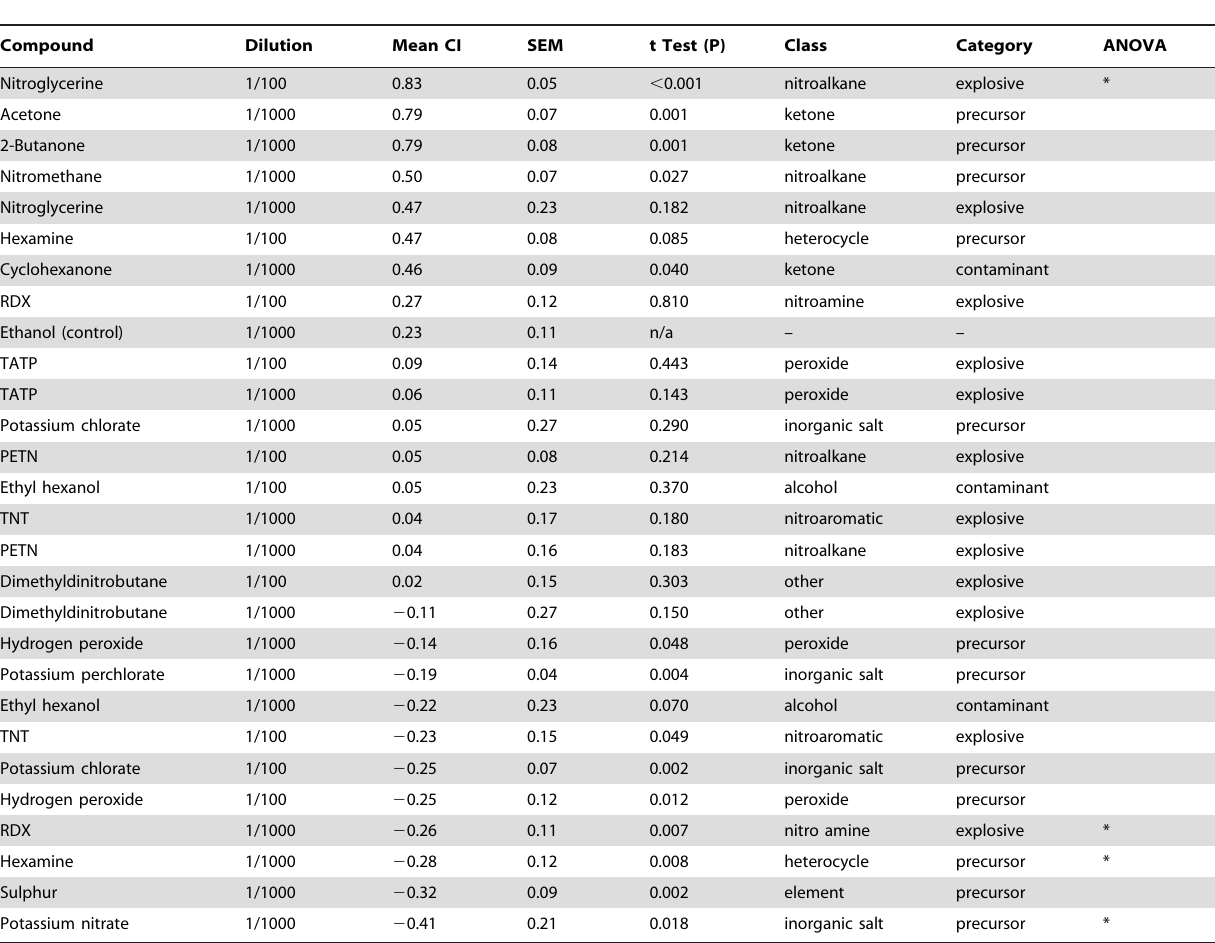
Table 1. Results of screening C. elegans for chemotaxis to a range of odorants associated with home-made and commercial